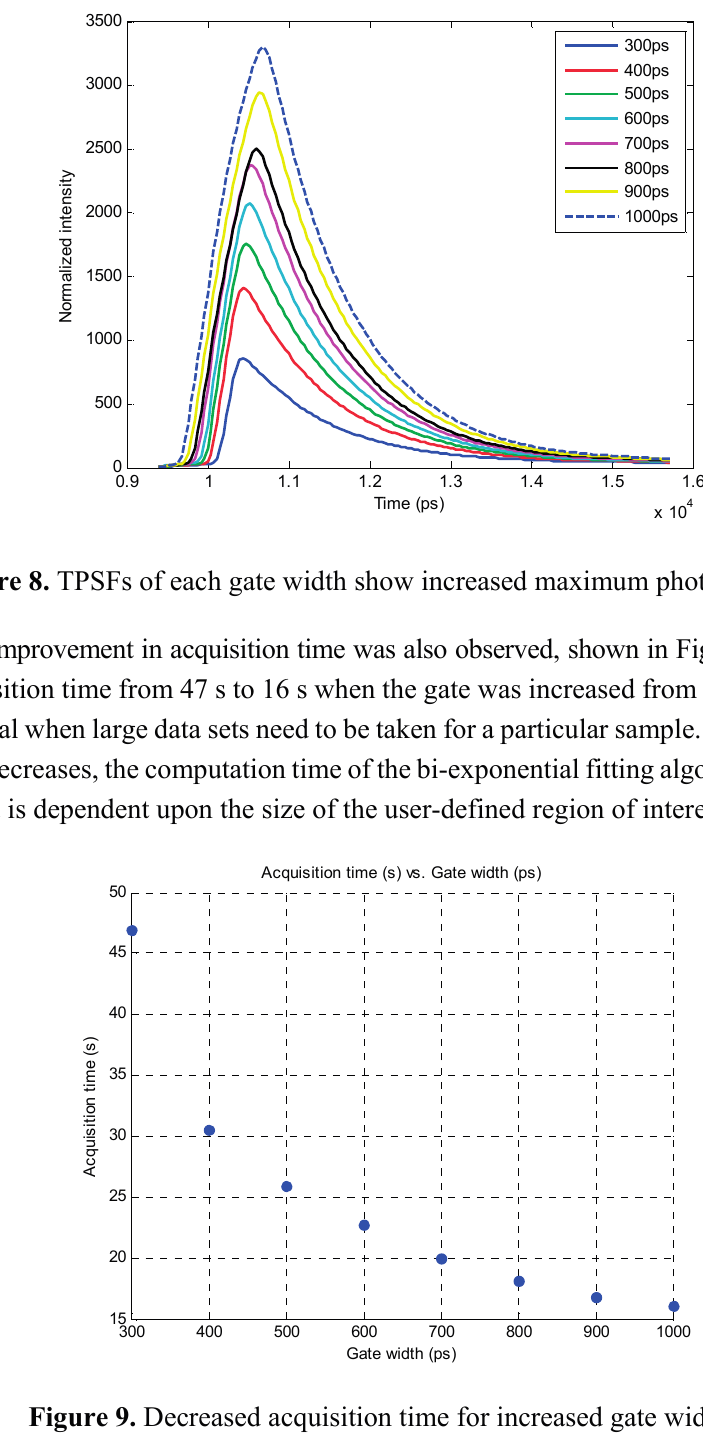
Figure 9. Decreased acquisition time for increased gate